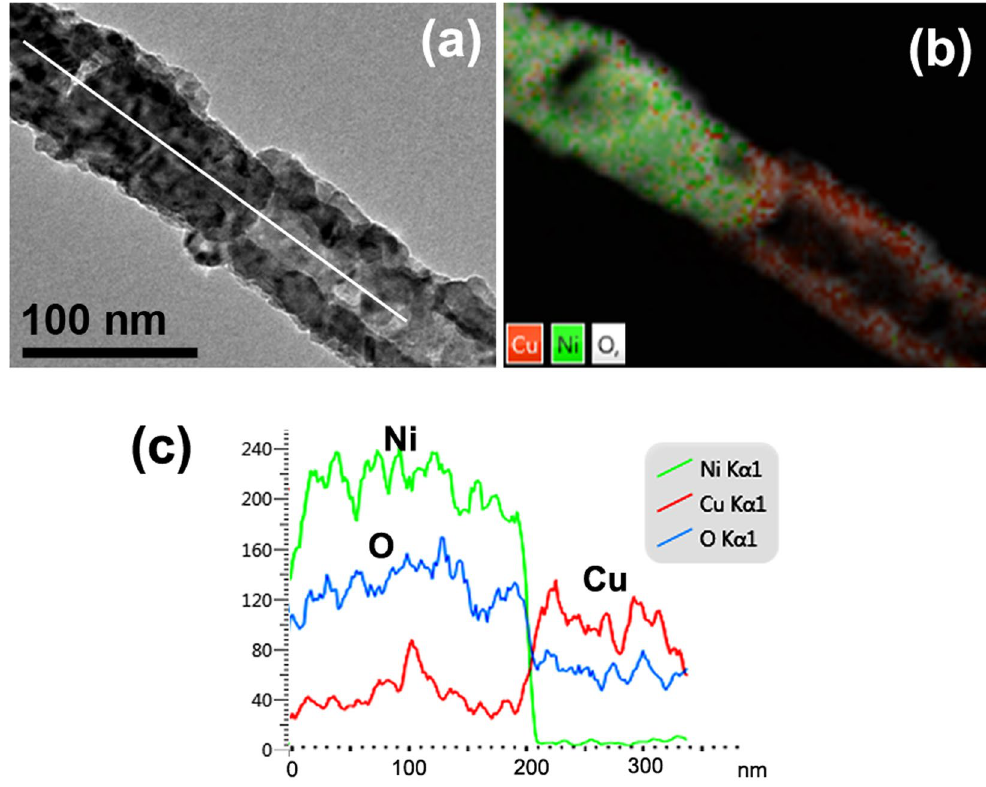
Figure 11. The compositional change at the interface. ( a ) TEM image of the interface between NiO and CuO; ( b ) the corresponding EDS element mapping image; ( c ) EDS line scanning image along the axis orientation as the white line shown in ( a ).